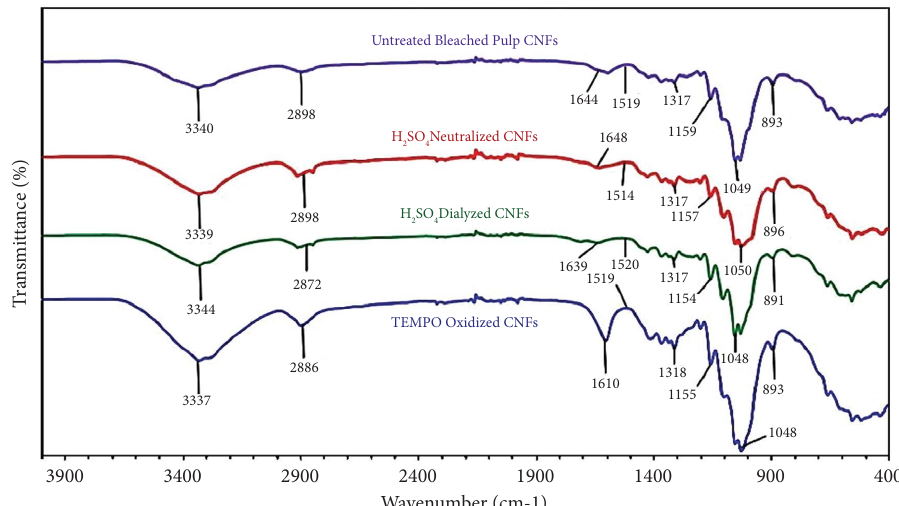
Figure 7: FTIR spectra of untreated bleached cotton stalk CNFs, neutralized sulfuric acid-treated cotton stalk CNFs, dialyzed sulfuric acid- treated cotton stalk CNFs, and TEMPO-oxidized cotton stalk CNFs. Te 3340 and 1040cm − 1 peaks had the highest spectral bands across all treatments. Based on the results of this FTIR analysis, all CNF cotton stalk treatments removed lignin and hemicellulose, as the peak at 1734cm − 1 vanished. Te glycosidic bond was discovered in approximately 890 cm − 1 cellulose peaks [163]. Copyright and permission from Elsevier-2015.